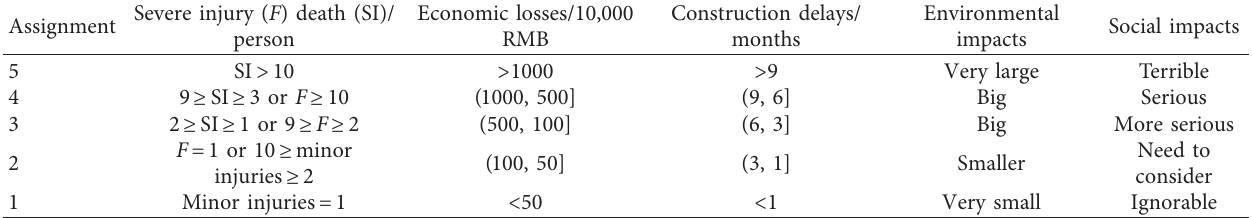
Table 2: Indexes of the consequence severity.